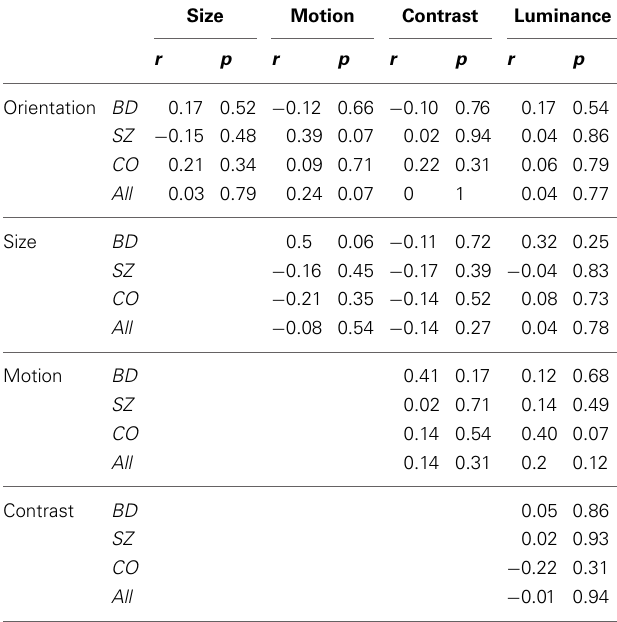
Table 4 | Intertask correlations within and across groups.